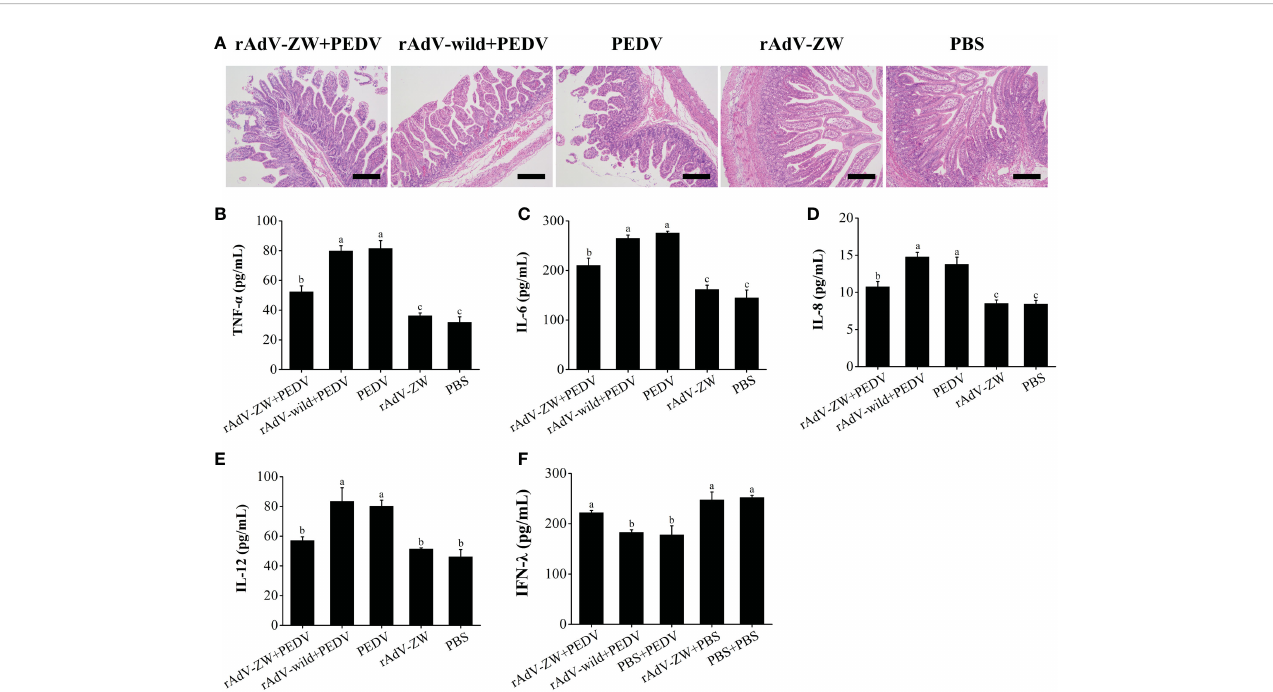
FIGURE 7 Histomorphological observations in jejunum and cytokine production levels in piglets. (A) Jejunum tissue underwent H&E staining to assess the effects of rAdV- ZW on jejunum pathological changes in piglets infected with PEDV. H&E staining showed that rAdV-ZW reduced jejunal damage severity. Scale bar = 200 m m. (B – E) Pro-in fl ammatory sera cytokine expression in piglets. At 3 dpc, TNF- a , IL-6, IL-8 and IL-12 serum levels were assayed using indirect ELISA. (B) TNF- a expression, (C) IL-6 expression, (D) IL-8 expression, (E) IL-12 expression, and (F) IFN- l expression pro fi les in piglet sera at 3 dpc. Values were presented as the mean ± standard error of the mean (SEM). Values indicated by different letters are signi fi cantly different (P < 0.05). No signi fi cant differences between values are indicated by identical